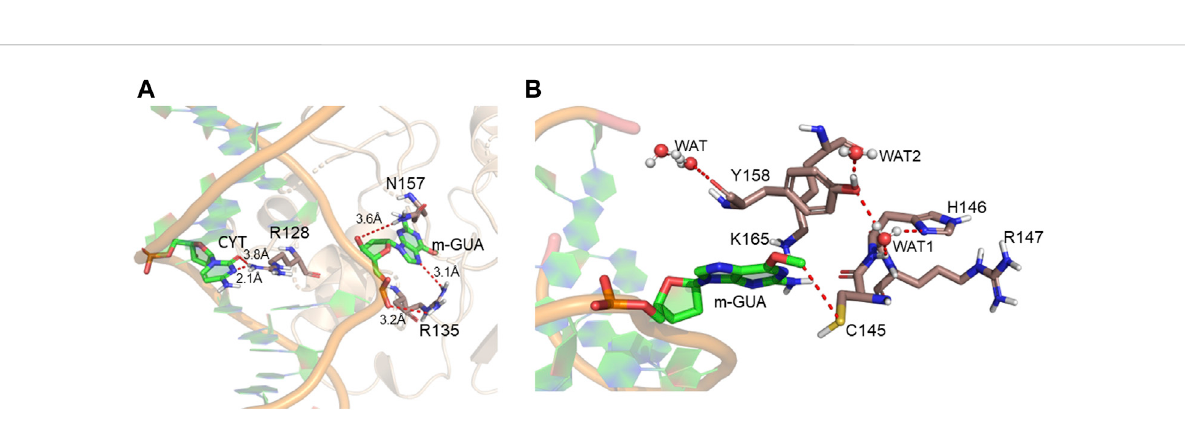
TABLE 1 Total binding free-energy calculations by the MMGBSA method. All values are in kcal/mol. Energy component Average Std. Dev. Δ E VDW